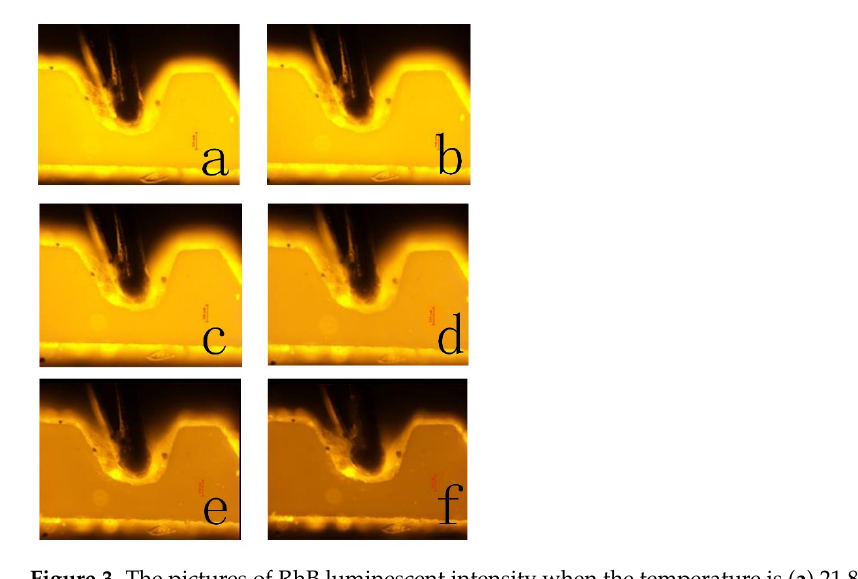
Figure 3. The pictures of RhB luminescent intensity when the temperature is ( a ) 21.8 ◦ C, ( b ) 28.8 ◦ C, ( c ) 34.5 ◦ C, ( d ) 40.8 ◦ C, ( e ) 47.2 ◦ C, and ( f ) 53.4 ◦ C. images of luminescent intensity were imported MATLAB and translated into intensity 123 images. Selected the luminescent intensity area and took the average grayscale. A line 124 was fitted by the relatively average grayscale and the temperature changing, as shown 125 in Fig. 4. The coefficients of c and d can be obtained form the line, which c = 0.27733304 126 and d = -1.9669431. 127 3.2. Measure the fluid temperature 128 The pump pumped the RhB solution into the channel. Then the pump was closed. 129 SSAWs were generated to heat the fluid. The frequency was 15.59 MHz. The input 130 voltages of the generator were 0.3 V, 0.4 V, 0.5 V, 0.6 V, 0.7 V, 0.8 V. Fig. 5 shows the 131